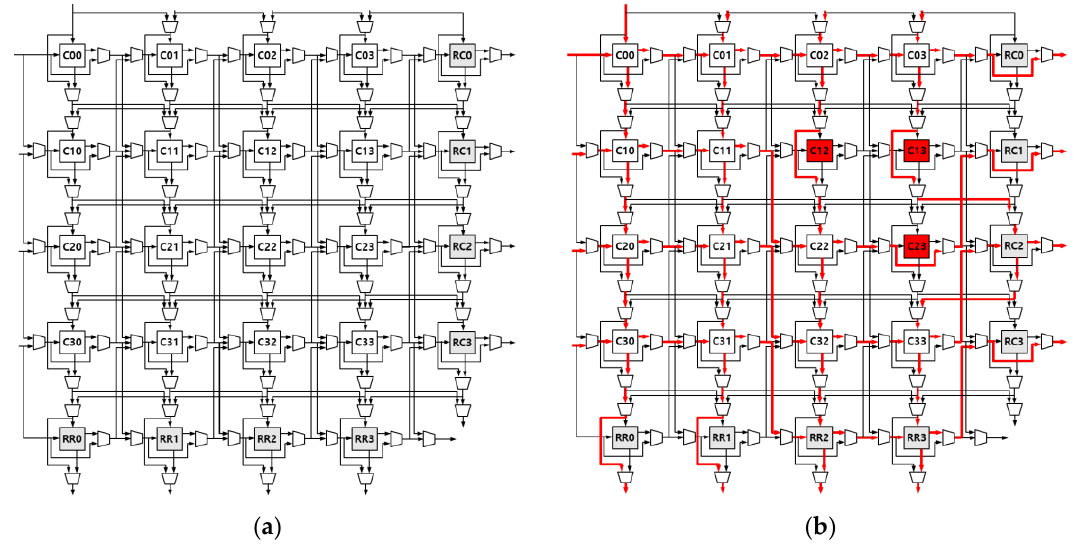
Figure 3. Redundancies in both rows and columns: ( a ) Overall architecture; ( b ) Repair